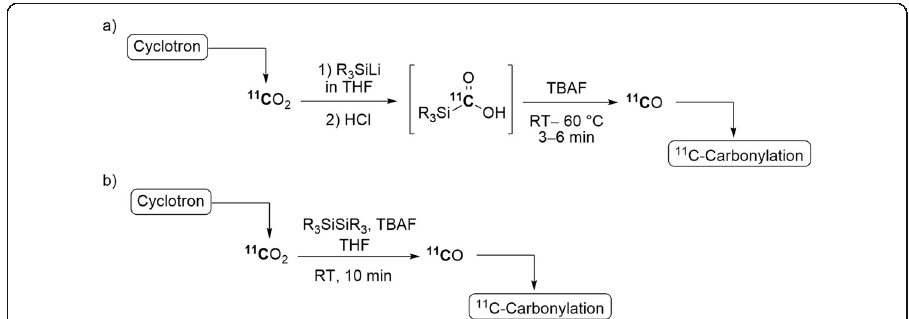
Fig. 4 ‘ Wet ’ [ 11 C]carbon monoxide production: a through decomposition of [ 11 C]silacarboxylic acids; b through fluoride-activated